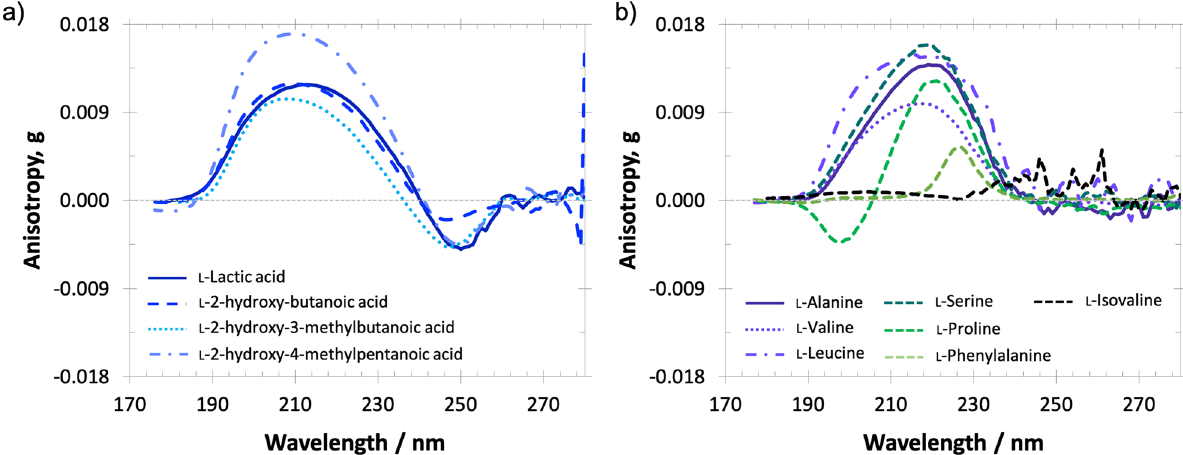
Fig. 2 Comparison of the chiroptical properties of two distinct families of chiral molecules detected in meteorites. Anisotropy spectra of a L -hydroxycarboxylic acids and b L -amino acids in aqueous solution. The same sign in the 170 – 280 nm wavelength range, which coincides with the dominant UV emission wavelength range of the majority of normal stars 31,63 , indicates the same handedness of induced ee following the interaction with broadband CPL. Permission to reproduce the original amino acid data 53 shown in ( b ) is acknowledged, © 2014 Wiley Periodicals,